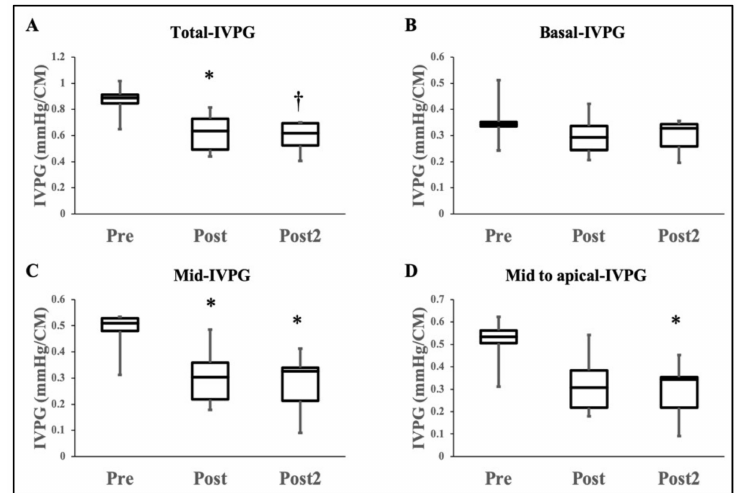
Figure 2. Box plots of the distribution of the IVPG indices. Data presented as mean ± SD. Pre is